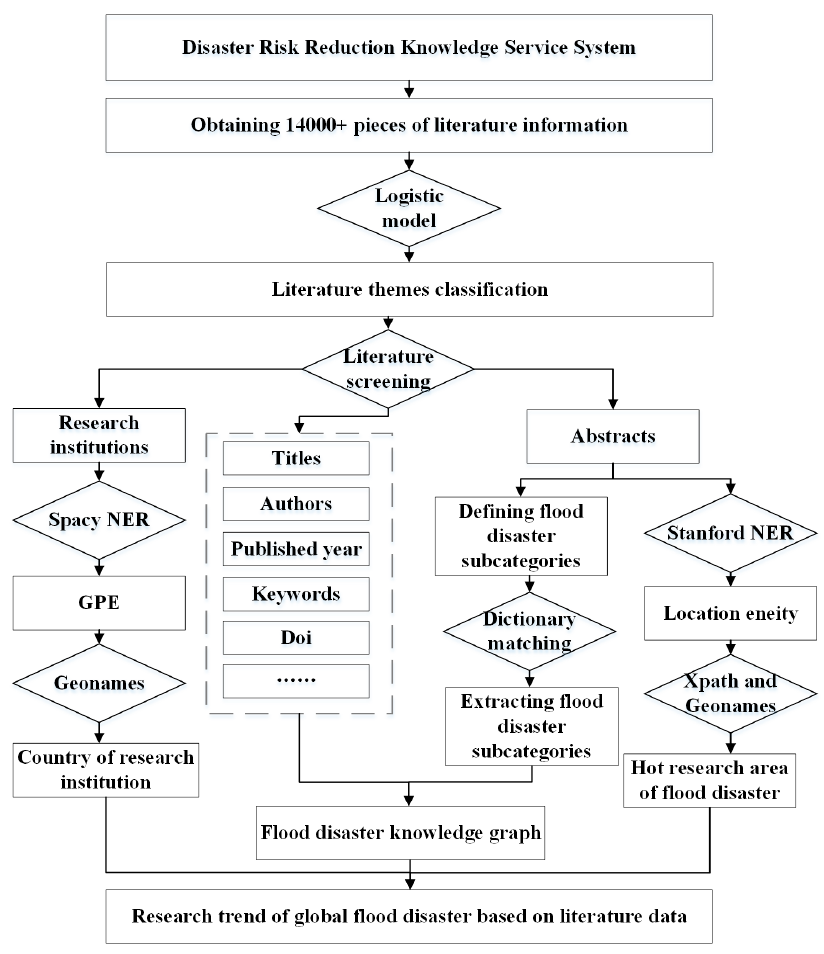
Figure 1. Technology roadmap.